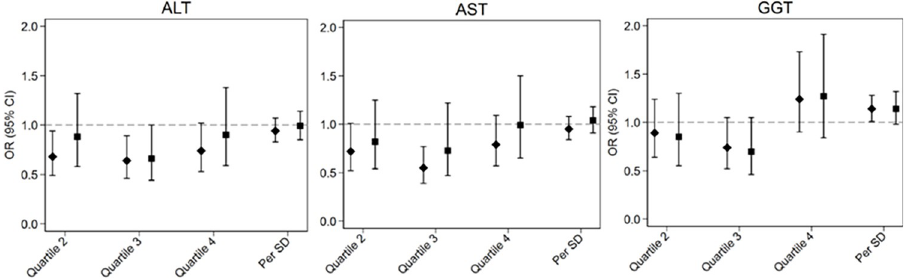
Fig 2. Odds ratios of cognitive impairment by AST, ALT, and GGT. ORs were calculated based on quartiles, comparing each higher quartile to the first quartile, and per SD increment. Quartiles were defined based on the distribution in controls. Diamond-shaped symbols denote Model 1 and squares denote Model 4 odds ratios. See Tables 3, 4 for model covariates.